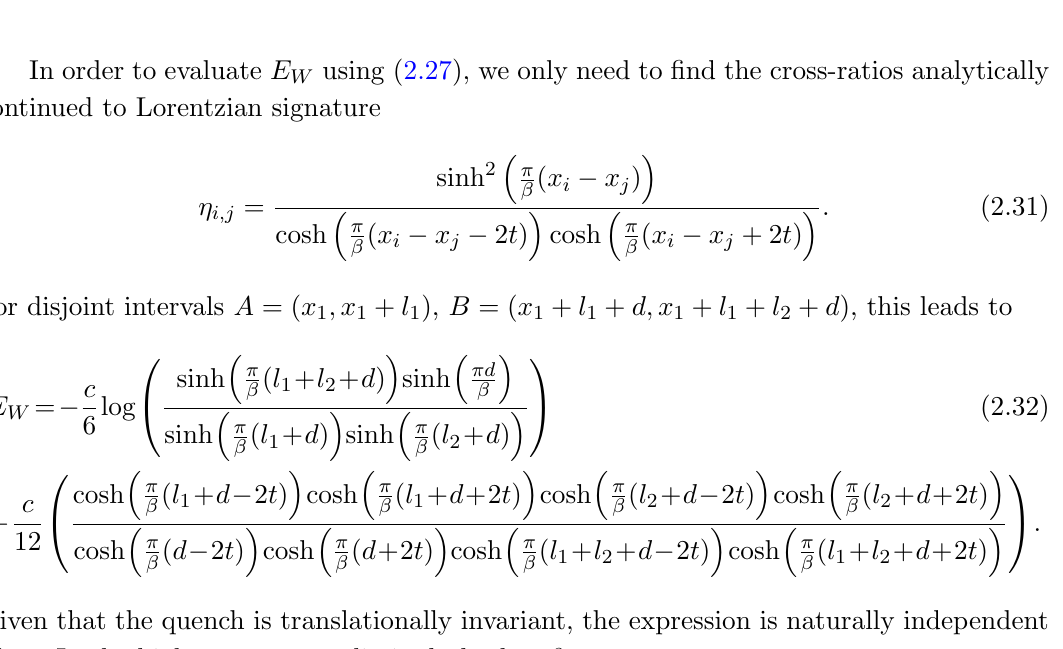
Figure 4 . Global homogeneous quench: (cid:12) = 2, c = 1 (left) l 1 = l 2 = 10, d = f 10 ; 25 ; 40 g (right) l 1 = 10, l 2 = f 10 ; 30 ; 50 g , d = 10. The maximum value of E W reached is dictated by half of the thermal entropy of the smaller interval. This is because right-moving quasi-particles in the right interval are maximally entangled with the left-moving quasi-particles in the left interval. However, the left (right)-moving particles in the right (left) interval are entangled with the environment. At late times, E W is exponentially small, given by the thermal value